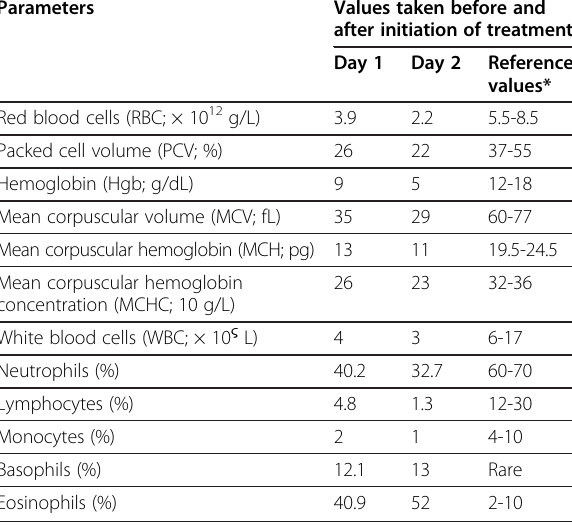
Table 1 Hematological values of a female German shepherd dog attacked by honeybees Parameters Values taken before and after initiation of treatment